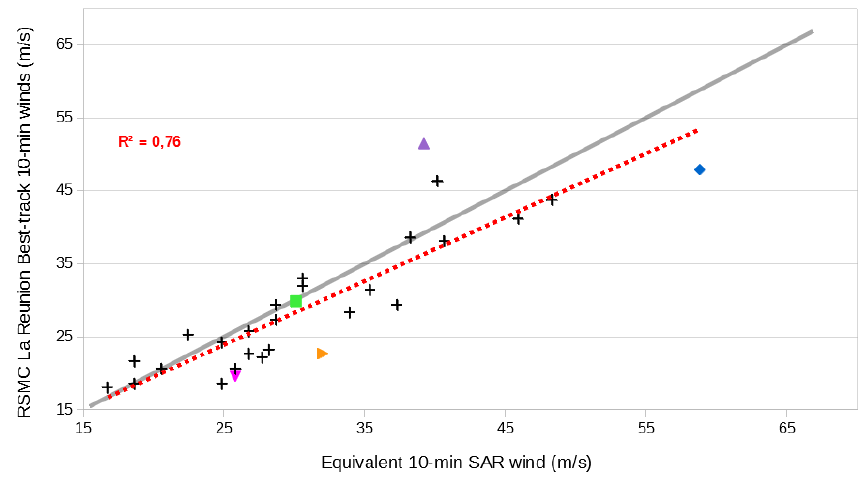
Figure 5. Comparison between equivalent 10-min SAR maximum winds SARMW and the RSMC La Reunion Best-Track maximum winds BTMW for 30 SAR overpass between February 2017 and March 2020. The red dot line shows the linear tendency with R 2 indicated. The colored symbols highlight the cases discussed in the text: the pink triangle with downward point refers to TC CARLOS (February 2017), the green square refers to TC GELENA (February 2019), the orange triangle with rightward point refers to TC FRANCISCO (February 2020), the purple triangle with upward point refers to TC JOANINHA (March 2019), and the blue diamond refers to TC IDAI (March